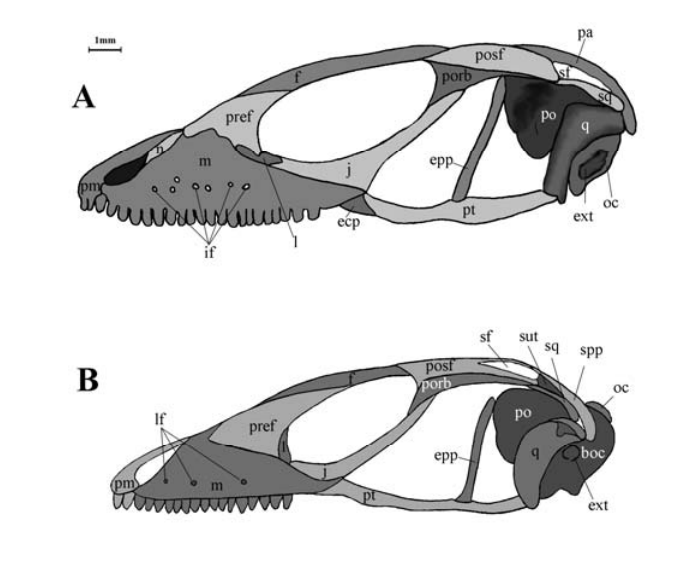
F IGURE 2. Left lateral view of the skull of Eremias persica (A) Mesalina watsonana (B) . Abbreviations: epp, epipterygoid; ex, exoccipital; lf, labial foramina; oc, occipital condyle; p, prootic; pt, pterygoid. Scale bar: 1